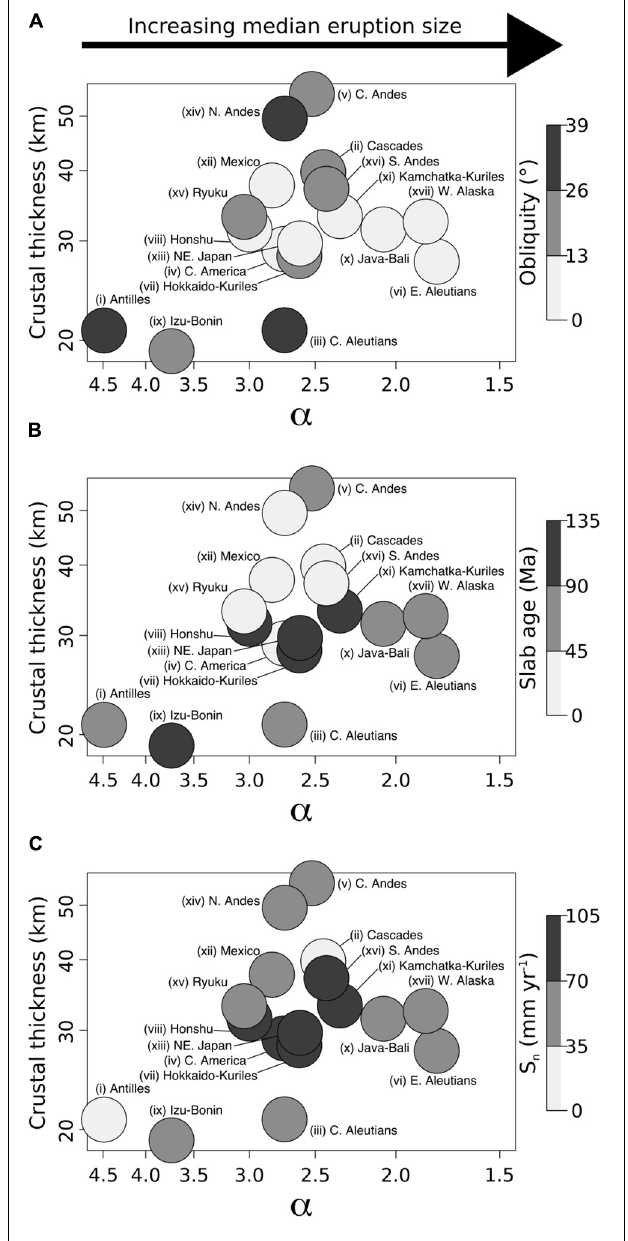
α ) versus the mean average crustal thickness (Z) for each arc. The graphs are color contoured for the average value of; (A) the obliquity of convergence (O); (B) the age of the slab (A); (C) the rate of subduction perpendicular to the volcanic arc (S n ). Note that the α parameter decreases to the right. Hence, the median size of volcanic eruptions increases to the